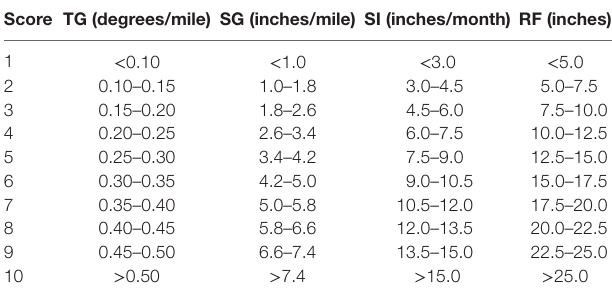
TaBle 1 | Scoring scheme for variables RT, RS, SI, and